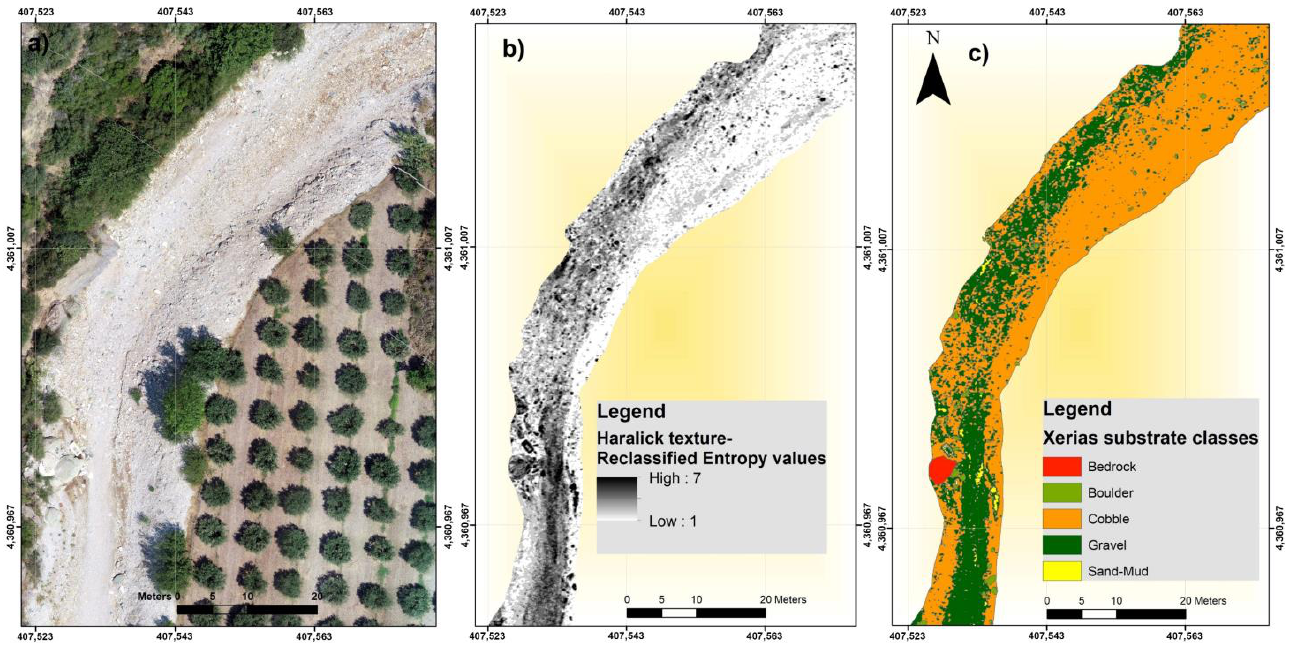
Figure 7. Orthophoto mosaic: ( a ) Simple Haralick Texture (entropy band) ( b ) and Stream-bed substrate classification ( c ) of a northern part along Xerias stream.